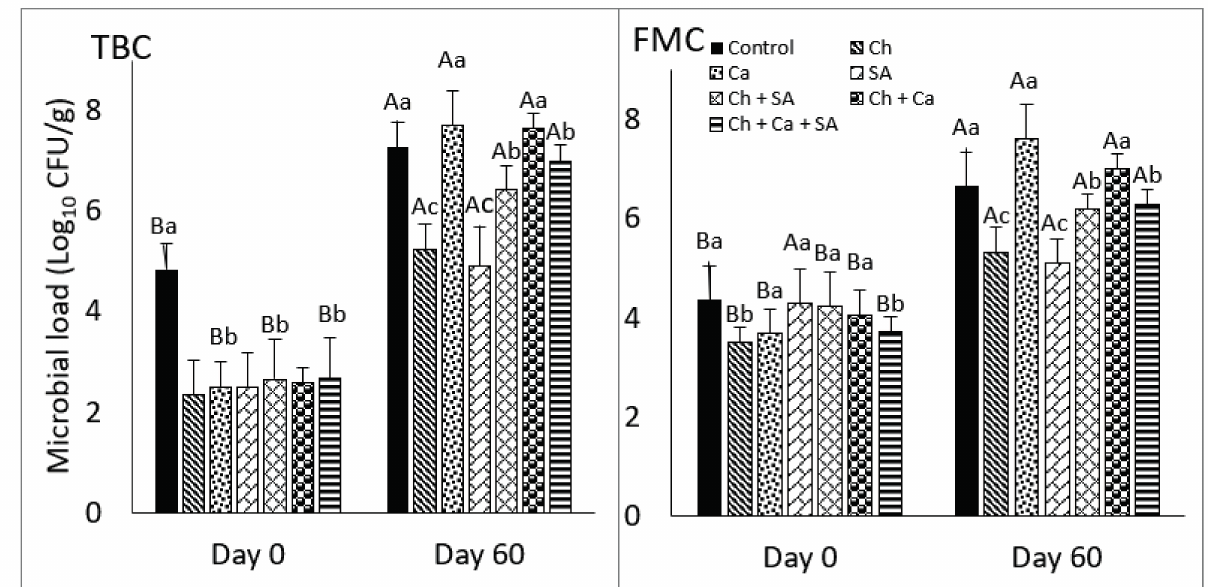
Figure 6. The effect of preharvest treatment on viable microbial load (Log 10 CFU/g) of ‘Khesab’ date fruit at day 0 and day 60 of cold storage. Values are the mean ( n = 3) ± SE. Means with different letters between treatments (small letter) at different time interval (capital letter) are significantly different at p < 0.05 using LSD test. TBC = Total Bacterial Count, FMC = Yeast and Mold Count. Ch: chitosan; Ca: calcium chloride; SA: salicylic